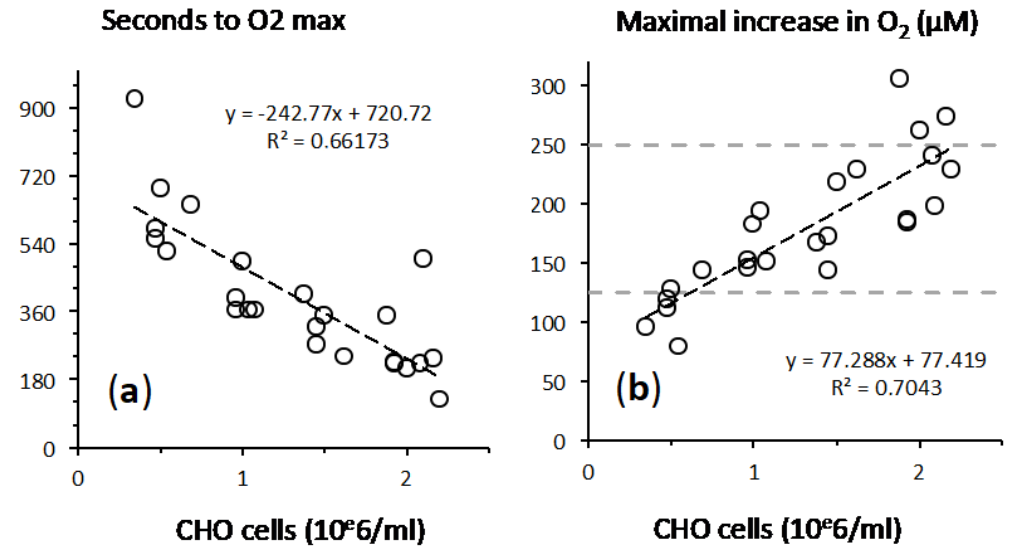
Int. J. Mol. Sci. 2020 , 21 , 9149 6 of 14 Figure 4. Influence of cell density on O 2 release. X axis = concentration of CHO cells exposed to a single addition of 500 µ M H 2 O 2 . ( a ) Time delay to reach the maximal O 2 increase, inverse to the reaction rate. ( b ) O 2 release in µ M with dotted grey lines figuring the values corresponding to a 50% and 100% yield of O 2 recovery from the catalase reaction (125 µ M and 250 µ M).